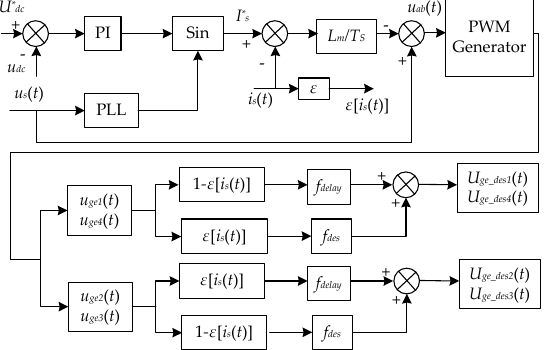
Figure 7. Control block diagram of the improved predictive current control.